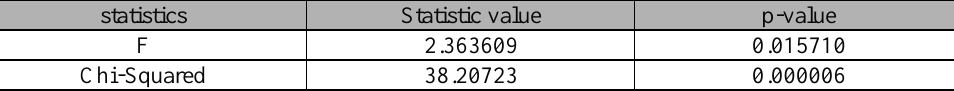
Table 6. Breusch-Pagan-Godfrey heteroskedasticity test for the first